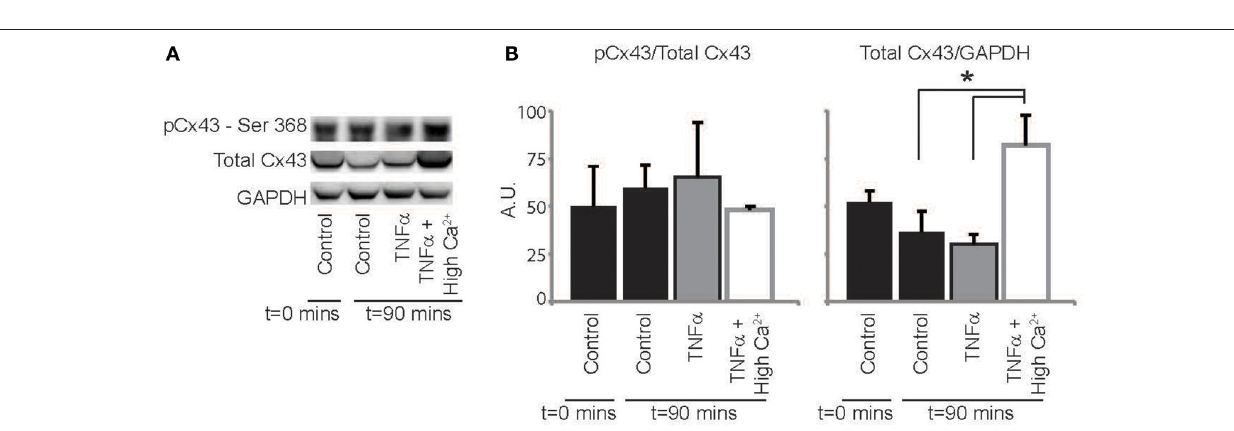
FIGURE 7 | Cx43 expression and phosphorylation modulation by TNF α (A) Representative images of membranes blotted for total Cx43, Cx43 phosphorylated at Ser368 and GAPDH as a loading control. (B) Protein expression in hearts treated with control, TNF α and TNF α + high calcium at t = 0 and 90 mins. *Indicates p < 0.05 by unpaired